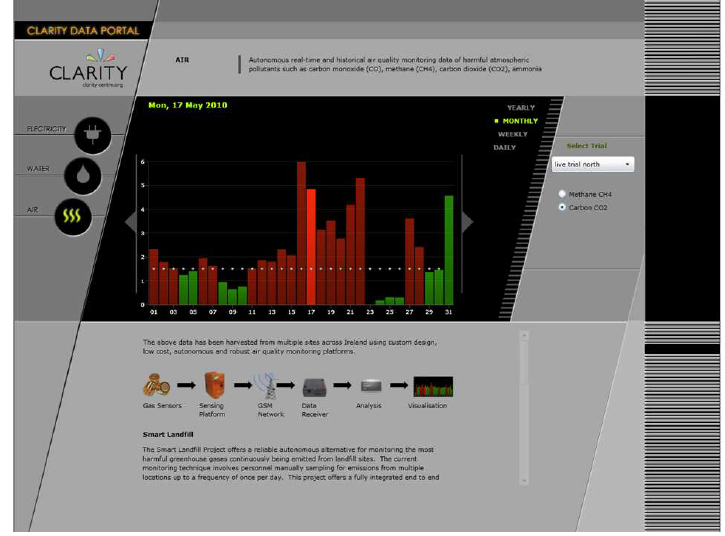
Figure 6. Sensor Data Portal: Our web application which allows relevant stakeholders to easily view in real-time the air quality (CO 2 & CH 4 ) data from landfill sites. The website can be viewed at